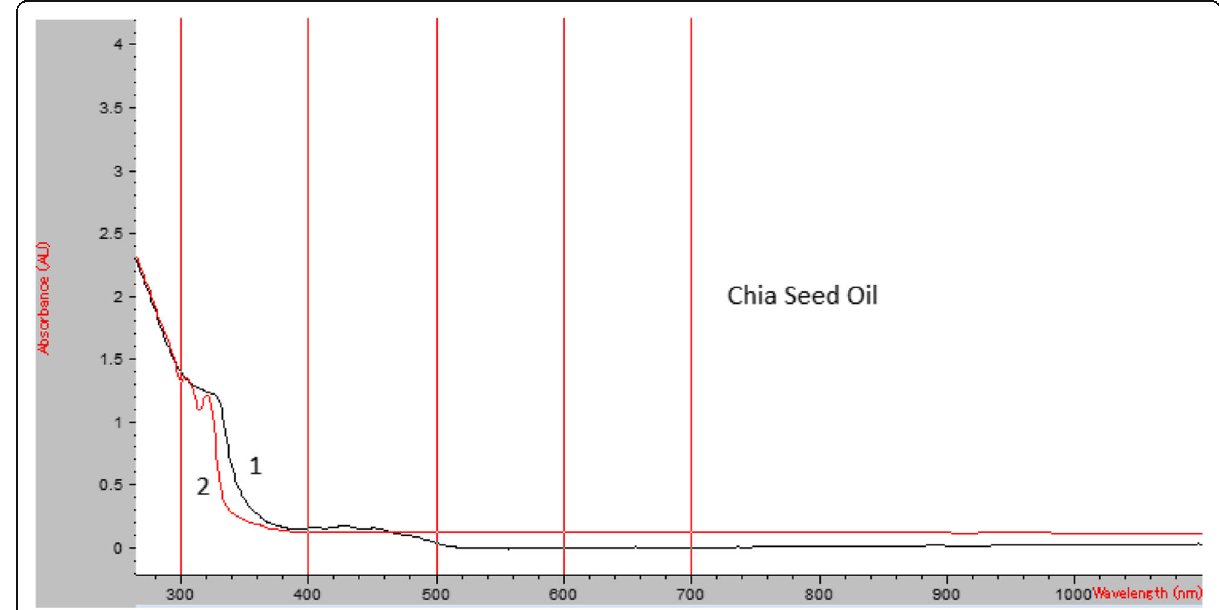
Fig. 1 Visible spectra of pigments in seed oils (1) original oil, (2) stripped